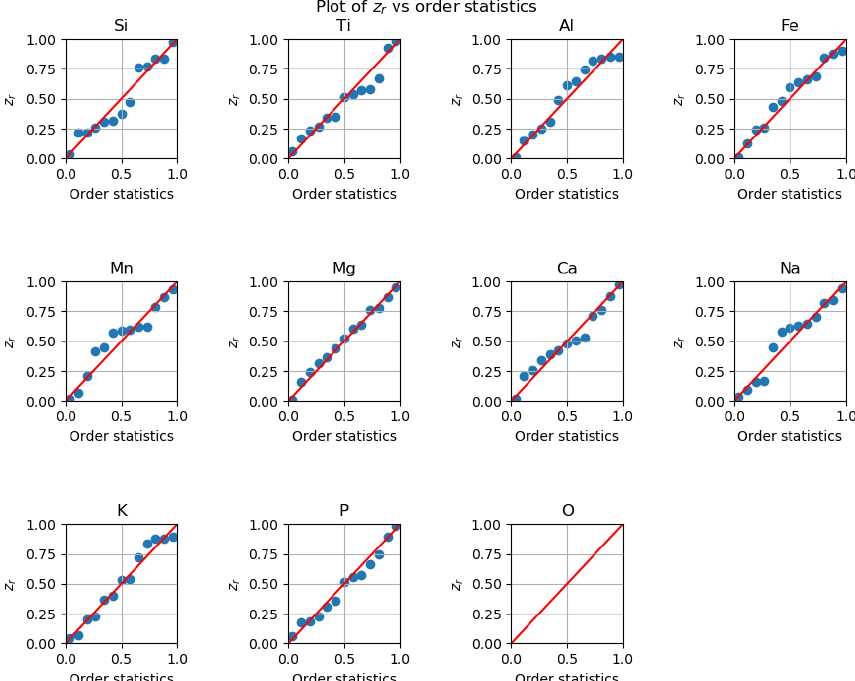
Figure B3. Visual test for multivariate normality of the log-ratio data from Table B3 (this plot shows the full dataset, of which Table B3 is only an excerpt). Each subplot checks for marginal normality. Oxygen is the denominator variable (arbitrarily chosen) and does thus not appear in the plot.